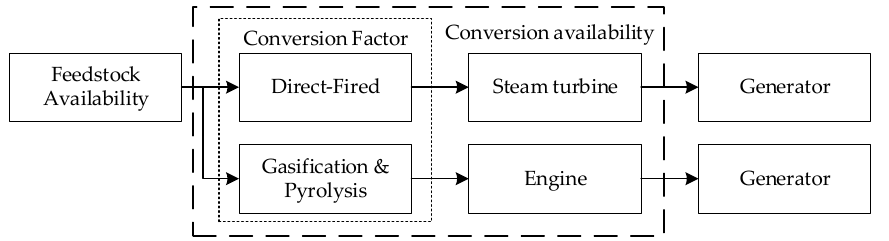
Figure 14. Basic operation model of biomass generation.